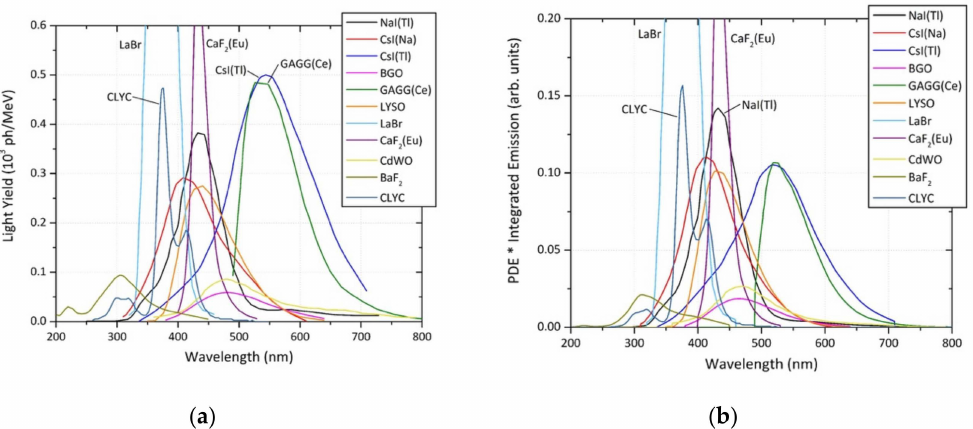
Figure 4. Optical emission characteristics of various scintillation materials; ( a ) absolute photon yield against the wavelength of peak emission; ( b ) e ff ective total optical yield, accounting for the quantum e ffi ciency of the light detector, against the wavelength of maximum